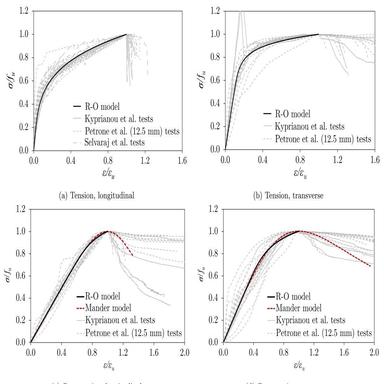
Comparison of the proposed model for plasterboard with normalised test curves for specimens of 12.5–15.0 mm thickness in (a–b) tension and (c–d) compression.